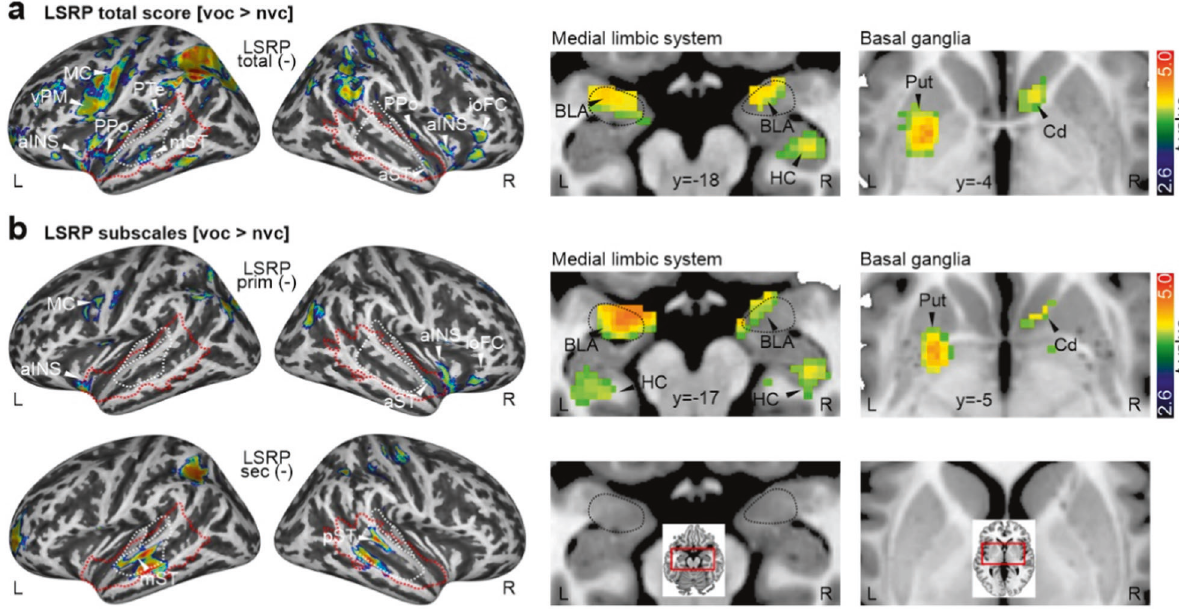
Fig. 3 Neural voice processing depending on psychopathic traits. a Increased cortical activity (left panels) as well as subcortical activity in the medial limbic system (BLA basolateral amygdala, HC hippocampus) and the basal ganglia (Put putamen, Cd caudate nucleus) for voice compared to non-voice sound with decreasing levels of the LSRP total score ( n = 113). b Same analysis as in a, but separately for LSRP primary (upper panel) and secondary factor (lower panel) ( n =